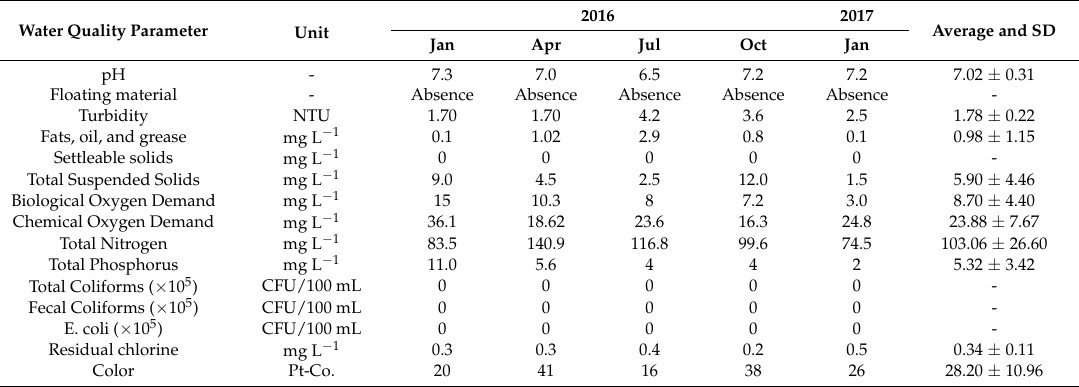
Table 7. Water quality parameters at the outlet of the disinfection system (SD = standard deviation). Water Quality